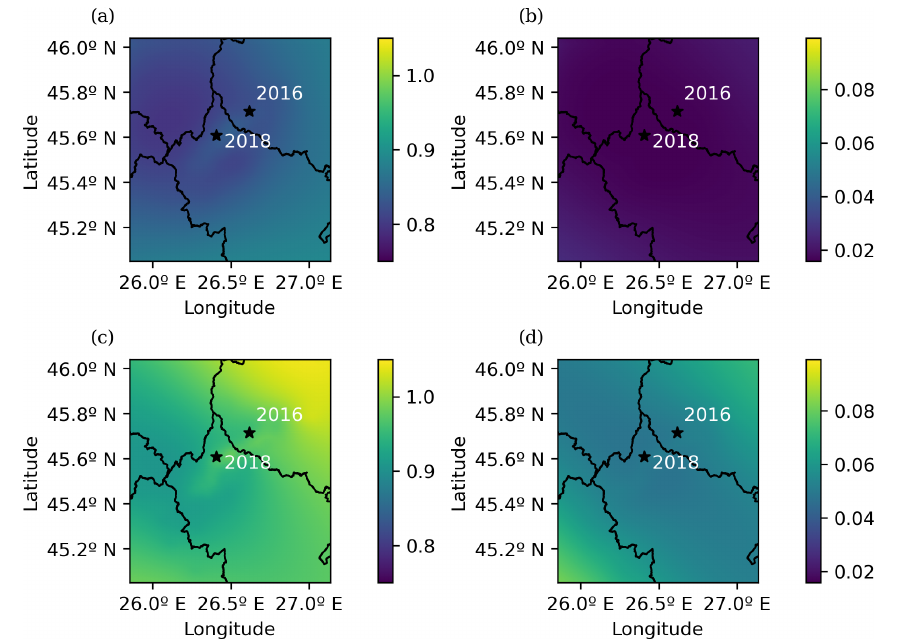
Figure 15. (a) The b -value spatial mapping for the Vrancea region from 2000 to 2016 using the parameters calculated in the previous exponential function fit, (b) b -value uncertainty for the Vrancea region from 2000 to 2016, (c) b -value spatial mapping for the catalog of the Vrancea region from 2016 to 2018 using the exponential kernel, (d) b -value uncertainty for the Vrancea region from 2016 to 2018. The black stars mark the epicenters of the earthquakes of 2016 and